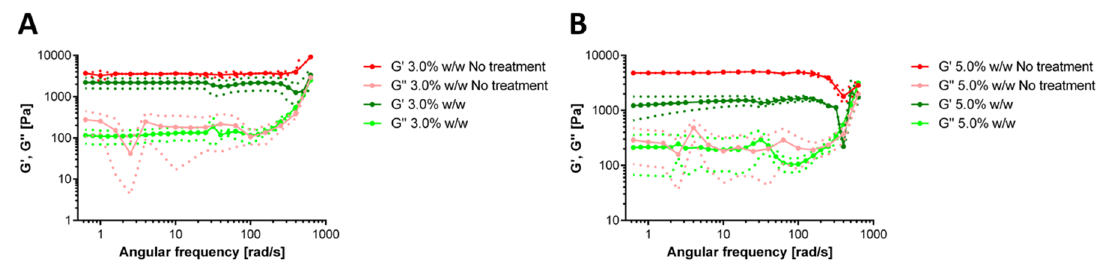
Figure 7. Storage and loss moduli for hydrogels after 72 h of milli-bioreactor operation and the comparison with a hydrogel without this treatment. 3.0% ( w/w ) ( A ) and 5.0% ( w/w ) ( B ) gelatin and for concentrations of GTA of 0.0%, 1.0%, 3.0% and 5.0% ( w/w ).